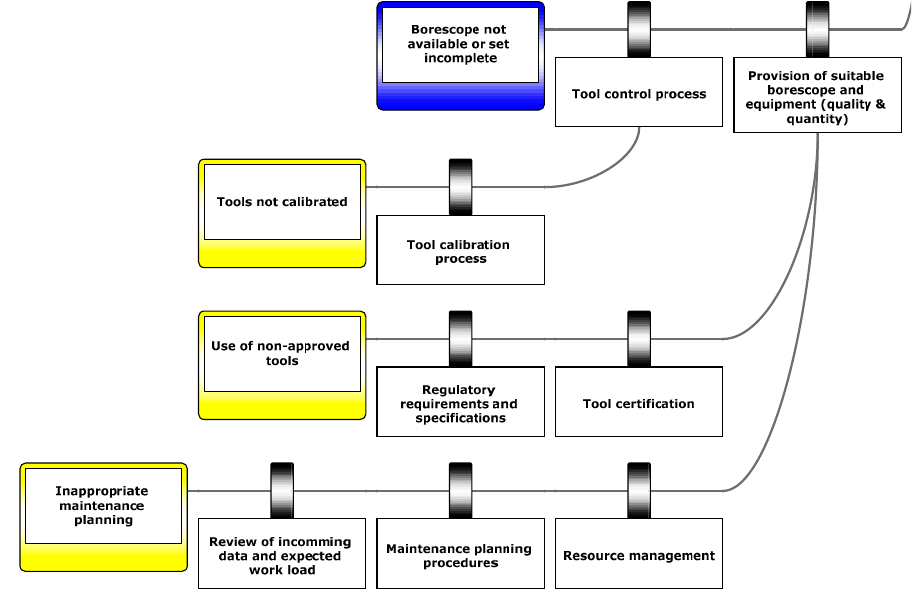
Figure A2e. “Tip lost during or left behind after inspection” threat path.